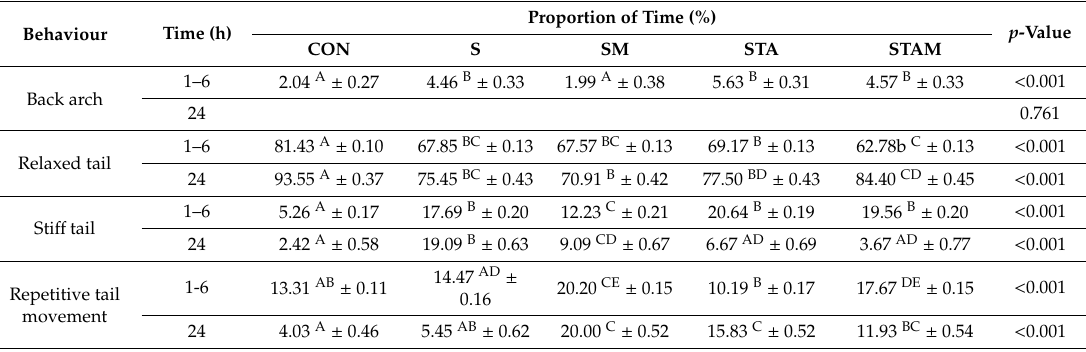
Table 5. Proportion of time spent exhibiting various back and tail positions or movements ( ± SE) by heifers in each treatment group at 1–6 h and 24 h post-procedure.